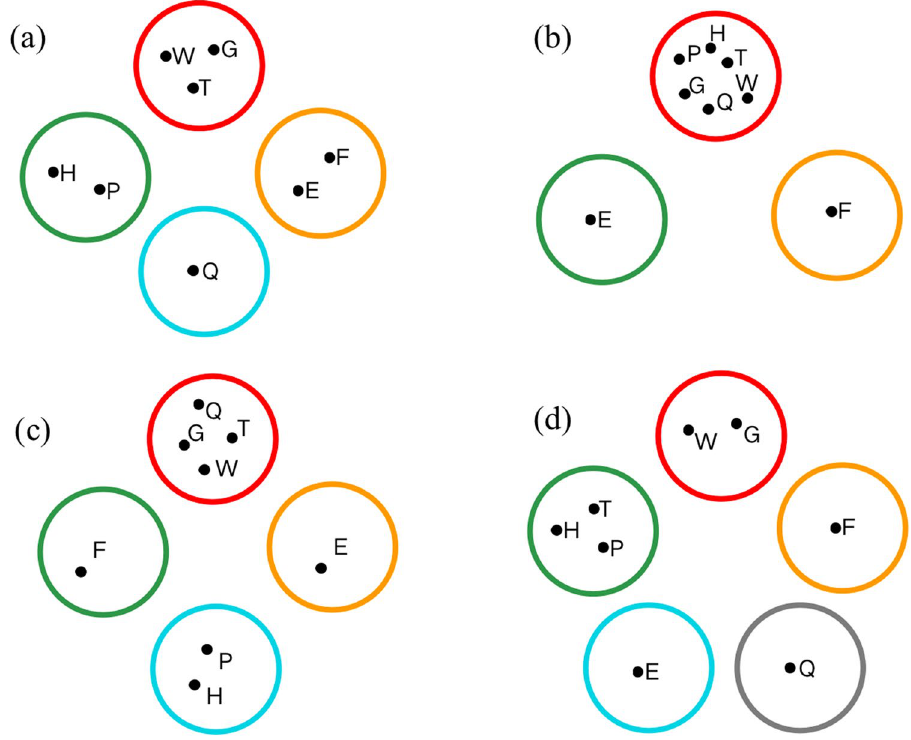
Figure 4. Online student behaviour classification: ( a ) PBCM, ( b ) Moore, ( c ) Wu, and ( d ) Peng.